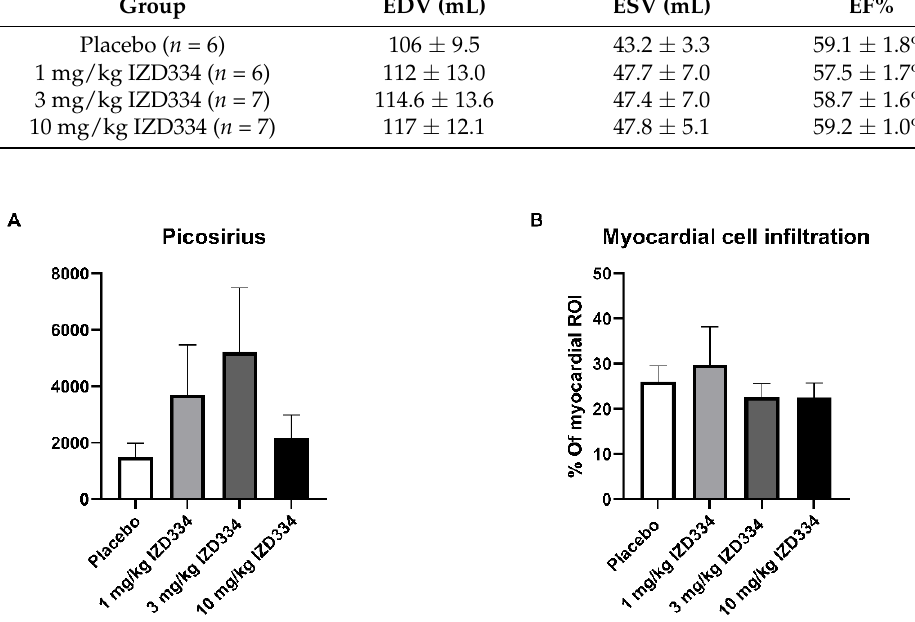
Figure A2. Histological analysis of infarct tissue ( n = 6–7). ( A ) Collagen formation. ( B ) Immune cell infiltration.